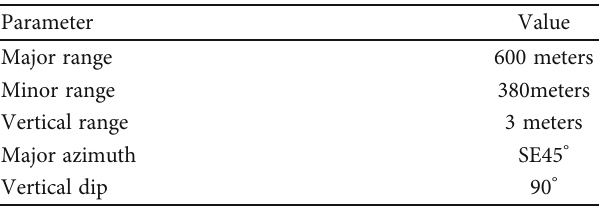
Figure 7: The work fl ow used for the entire modeling procedure. Table 3: The variogram fi ts the input parameter